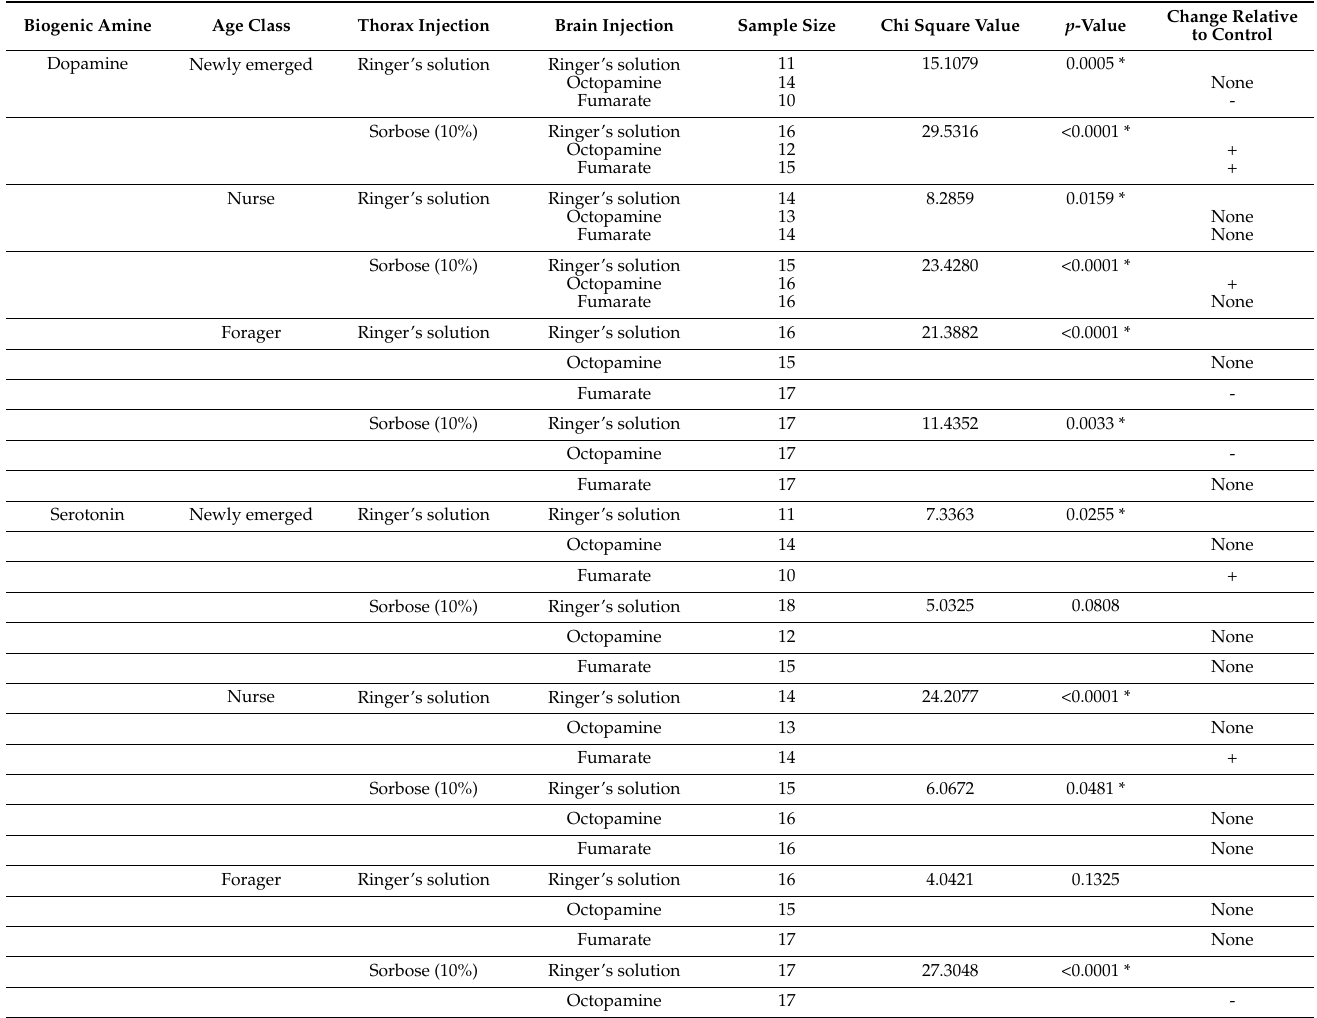
Table 1. A summary of the statistical output from the Kruskal–Wallis tests carried out on the biogenic amine levels within each age class and thorax injection treatment, across each brain injection treatment. The * besides the p -value indicates significance at the alpha = 0.05 level. The change in the biogenic amine levels relative to the control is indicated within the last column, a + indicates significantly higher level, while–indicates significantly lower levels. None indicate no significant changes in the biogenic amine level relative to the